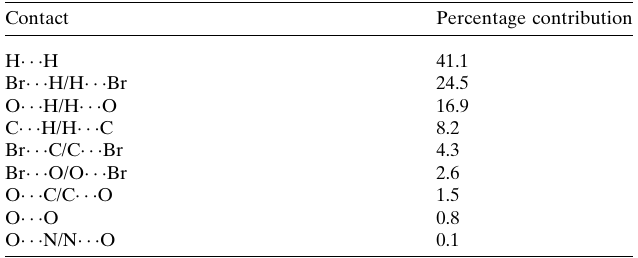
Table 3 Percentage contributions of interatomic contacts to the Hirshfeld surface for the title